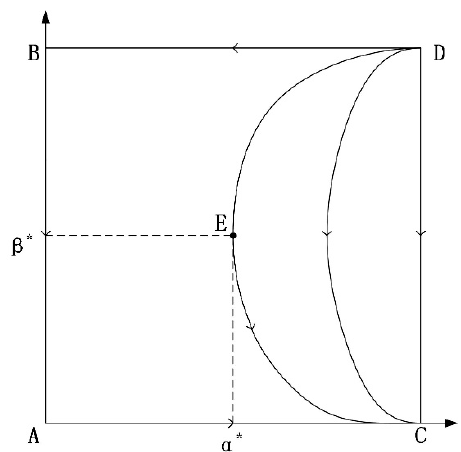
Figure 6. Scenario 1 evolutionary path between local government and the public.